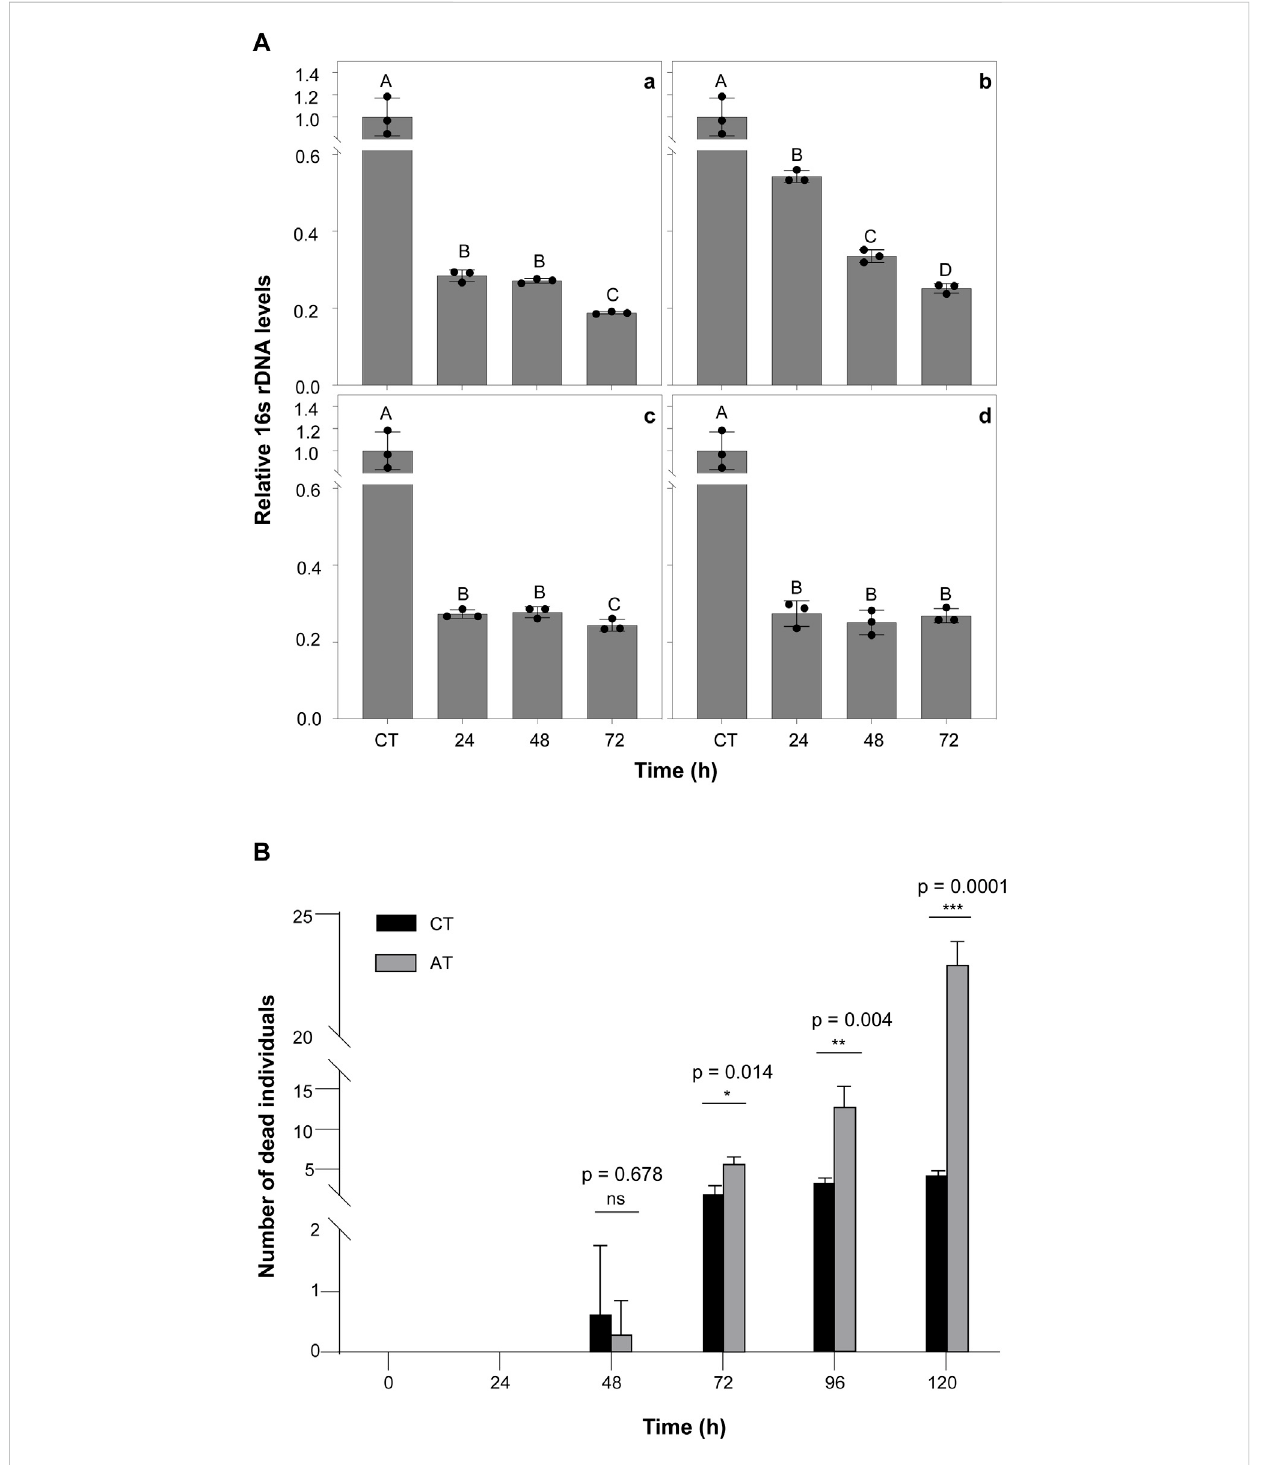
FIGURE 1 TheEffectofAntibioticsonTermites (A) Theeffectsofantibiotictreatmentonbacterialsymbiontabundanceinthetermitegut.TheqPCRresultsfor total bacteria in the guts of termites treated with 5% Kanamycin (a), 5% Ampicillin (b), 5% Streptomycin (c), and 2.5% Tetracycline (d). β -actin was used to normalizethedata,whichareshownasmean±standarderror;themeanwasobtainedfromthreeindependentreplications.The2 − ΔΔ CT methodwasused to calculate the relative expression level. Statistical differences between time points, determined with an unpaired t -test, are shown via GraphPad Prism8. Different letters indicate signi fi cant differences (B means p < 0.0001, C means p < 0.05). (B) Number of dead termite individuals fed with 5% kanamycin.AT termites were fed with 5% kanamycin, while CT termites were fed with sterile water. The experiments were performed in three biological replicates. Kanamycin signi fi cantly increased mortality compared with the control group after 72 h ( p < 0.05). The experiments were performed in three biological replicates (n = 30 per replicate). Statistical differences between treatment at every time points, determined with an paired t -test, are shown via GraphPad